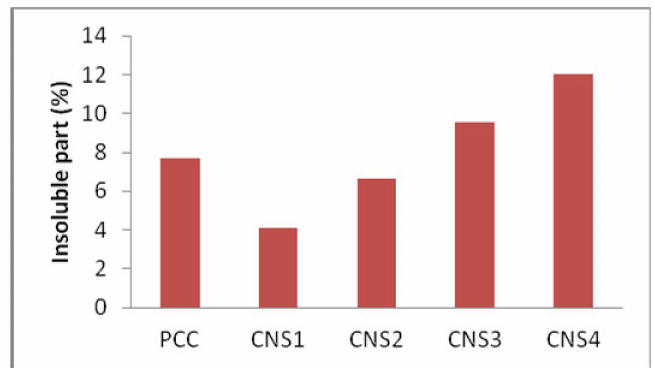
Figure 6. The effect of Napa soil usage on the insoluble